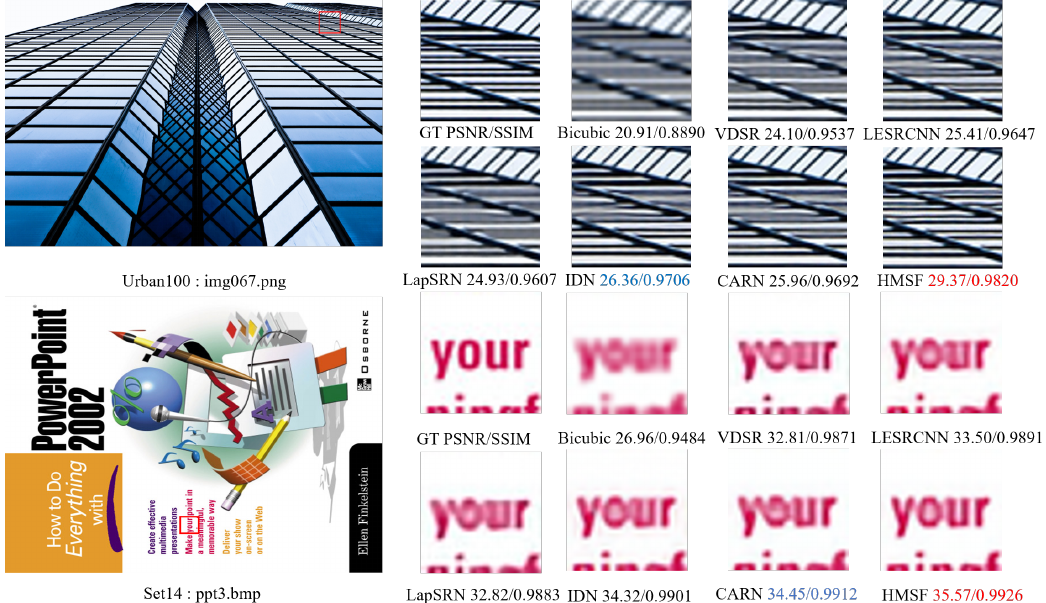
Figure 10. Visual qualitative comparison on 2 × scale